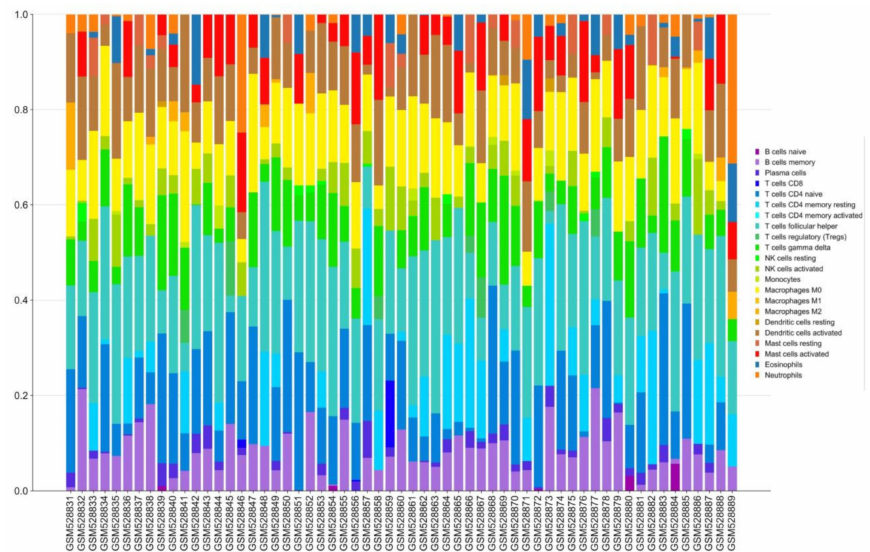
Figure 10. Immune infiltration analysis was conducted in combination with a signature matrix for 22 types of immune cell composition of the prefrontal cortex of patients with schizophrenia and healthy people.